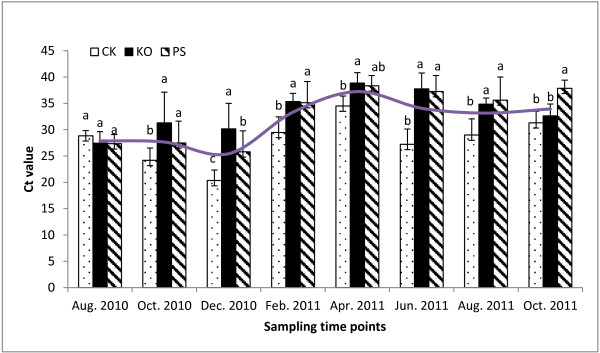
qPCR Ct values of ‘Candidatus Liberibacter asiaticus’ (Las) in Huanglongbing (HLB)-affected citrus treated with antibiotic combinations. The higher Ct values represent lower Las bacterial titers in the samples. (i) Severe HLB-like symptoms with Ct values <26, and Las bacterial titers of more than 770,000 cells per gram plant tissue, (ii) no symptoms with Ct values ≥36.0, and Las bacterial titers of less than 1,060 cells per gram plant tissue. PS: 5 g/tree penicillin G potassium and 0.5 g/tree streptomycin; KO: 2 g/tree oxytetracycline and 1.0 g/tree kasugamycin; and CK: water as control. The different letters on the bars represent the significance at the 0.05% level (Pr<0.05). The smooth top line represents the seasonal fluctuation of the Las bacterium.